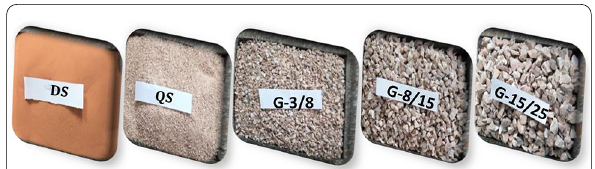
Fig. 2 Granular classes used ( DS , QS , Gravels 3/8, 8/15 and